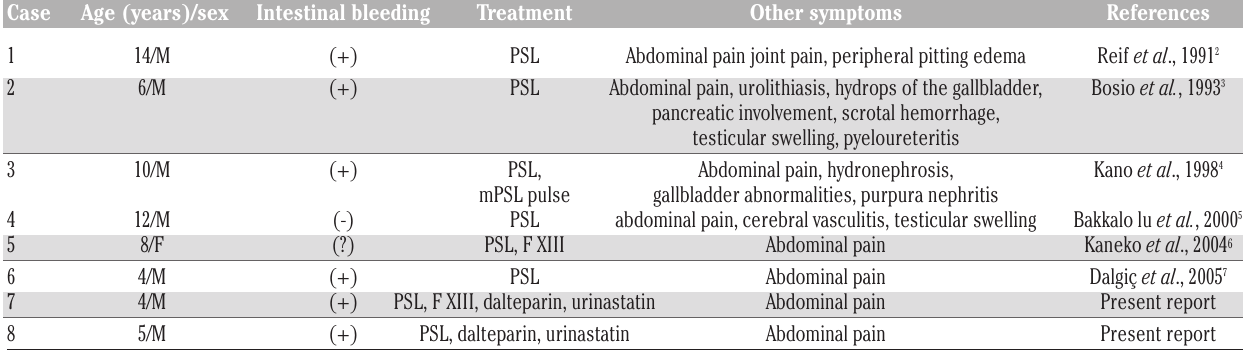
Table 1. Pediatric Henoch-Schönlein purpura patients with protein-losing